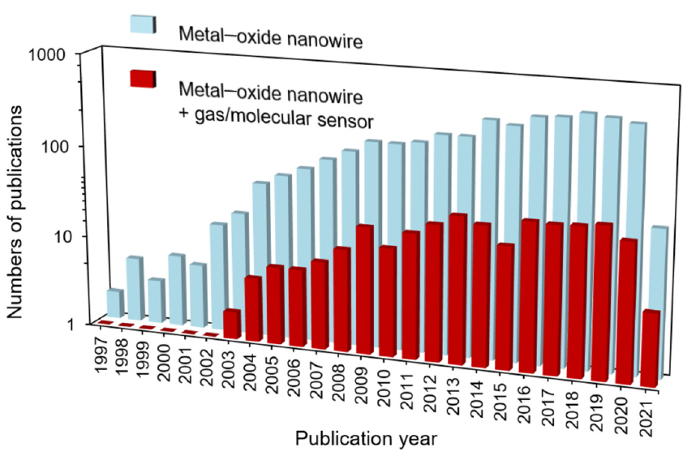
Figure 1. Numbers of publications in the area of nanowires and nanowire sensors from 1997 to 2021 (internet search of the Web of Science on 15 January 2021). Keywords for search: metal–oxide nanowire; metal–oxide nanowire + gas/molecular sensor.